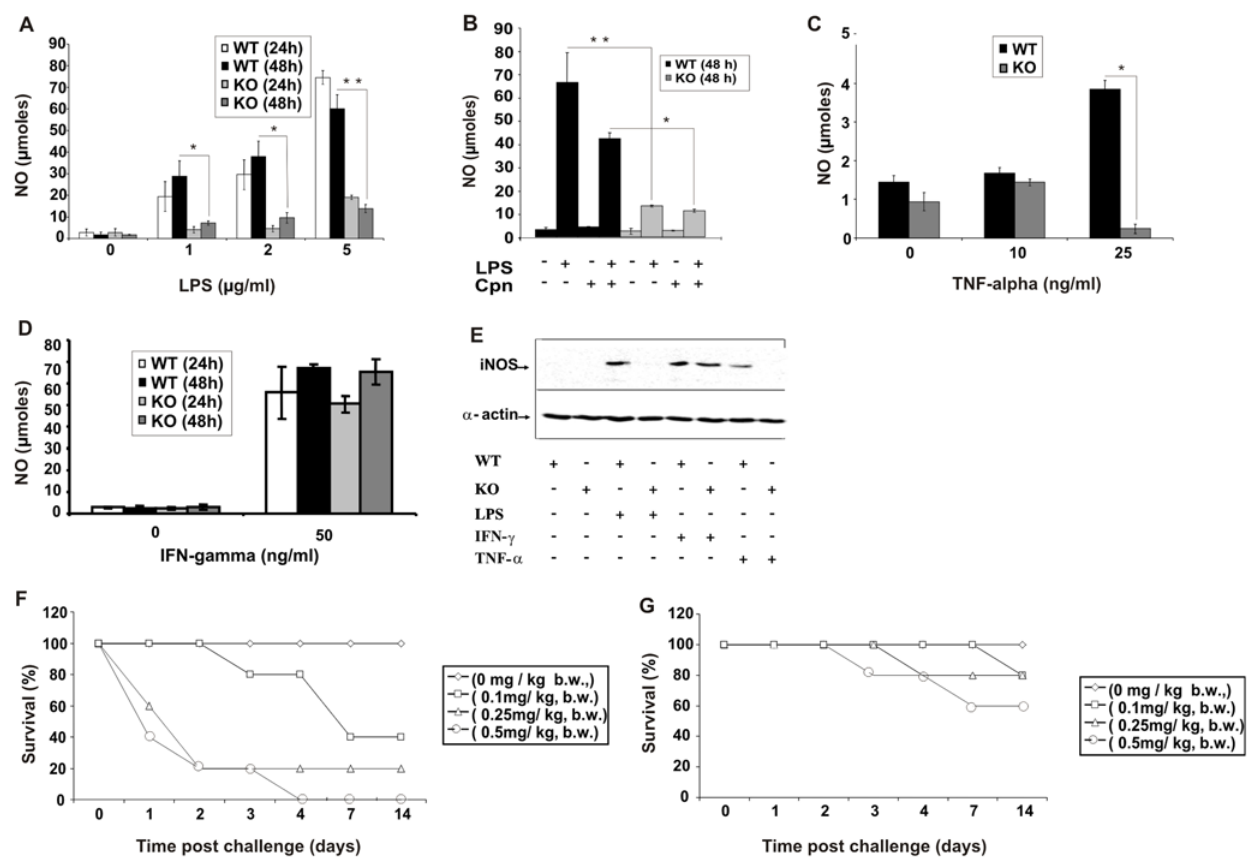
Figure 4. cIAP-1 is required for nitric oxide production in response to LPS and TNF- a in peritoneal macrophages. A. Macrophages from wildtype and cIAP-1 KO mice were stimulated with different doses of LPS and the NO titer was determined in the culture supernatant at the indicated time points post treatment. B. LPS- and infection- (Cpn) induced NO production in cIAP-1 KO and wildtype macrophages. 1 6 10 4 peritoneal macrophages were infected with C. pneumoniae at an MOI of 1. Cells were treated with LPS 30 min after infection and further incubated at 37 u C for 48 h. NO generation was quantified in culture supernatants. C. TNF- a -induced production of NO in cIAP-1 KO and wildtype peritoneal macrophages 24 h post treatment. Both wildtype and cIAP-1 KO macrophages were cultured and stimulated with the indicated doses of TNF- a and NO was measured in the supernatant 24 h post induction. D. IFN- c -mediated NO production in KO and wildtype macrophages. 1 6 10 6 macrophages were stimulated with murine IFN- c and NO were determined in culture supernatants 48 h later. The data are presented as the mean 6 SEM from three independent experiments. E. cIAP-1 is required for the induction of iNOS by LPS and TNF- a in mouse macrophages. The cells were incubated with the indicated reagents and the levels of iNOS were determined by western blot of whole cell lysates. a -actin was detected as loading control. F and G. Resistance of cIAP-1 KO mice against LPS-induced endotoxin shock. Mice were treated with different doses of LPS intraperitoneally (from 0.1 to 0.5 mg/kg body weight [b.w.]) and the survival of wildtype (F) and cIAP-1 KO mice (G) was monitored over a 14 day period. Shown are the representative results of one out of three independent experiments. * p # 0.05; ** p # 0.01.